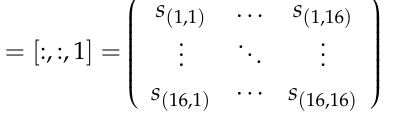
Figure 4. The structure of the data set.